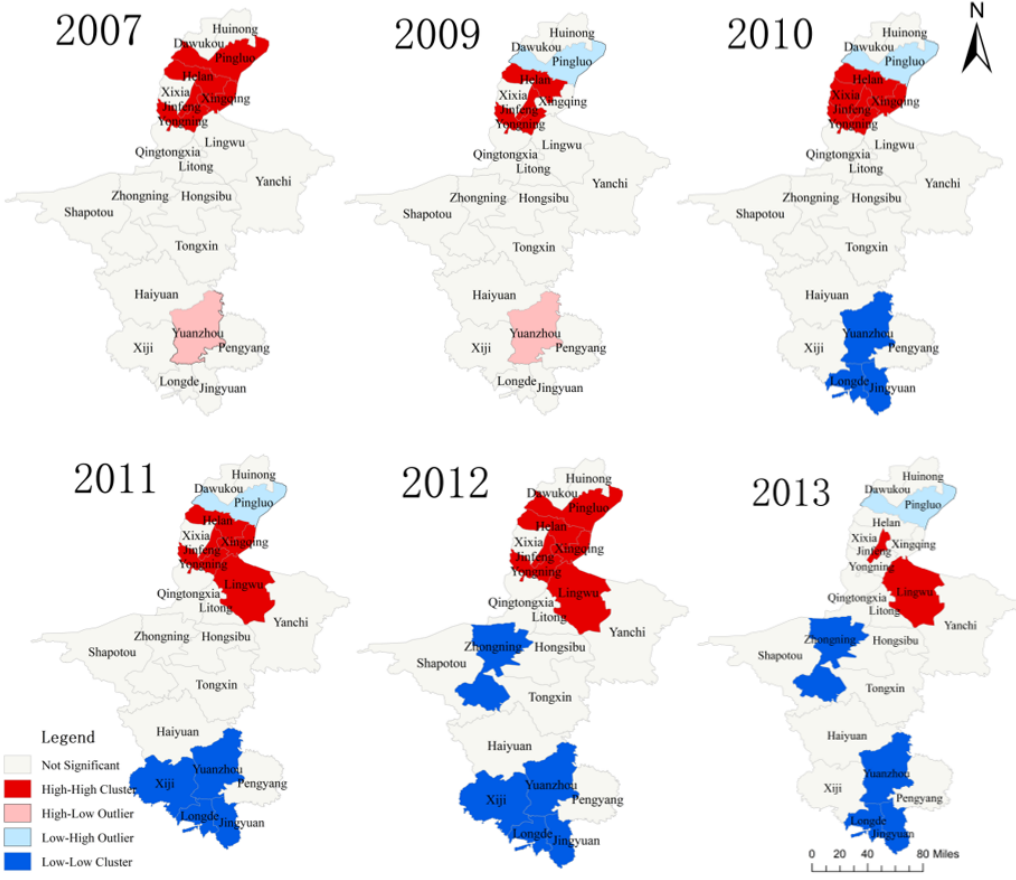
Figure 3. Local indices of spatial association aggregation plots of syphilis SMR values in Ningxia.